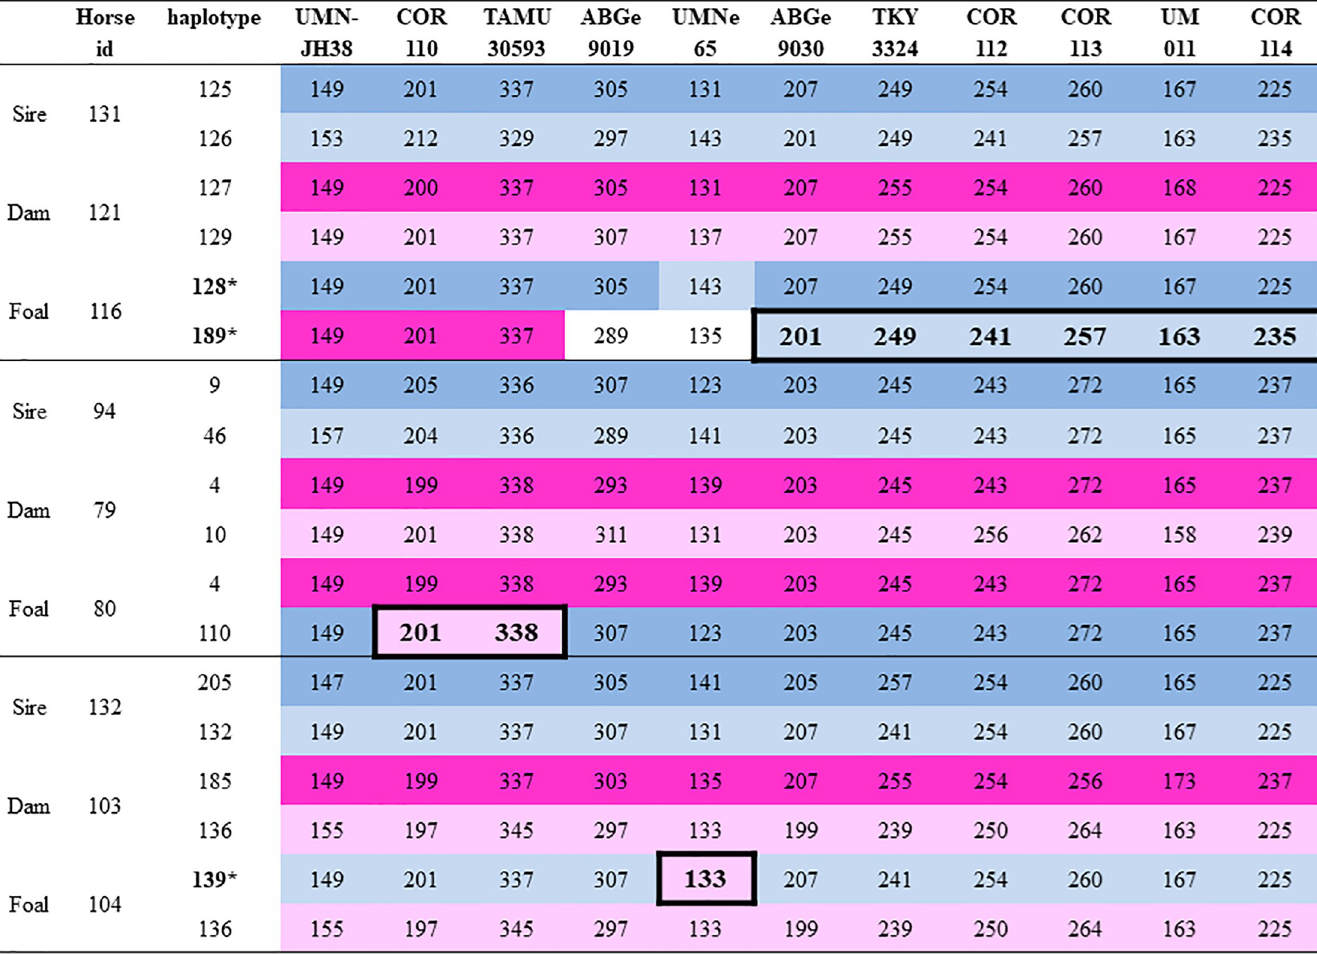
Fig 4. Events of intra-MHC conversion present in the offspring (foal 116, foal 80, foal 104). Fragments of haplotypes which were converted are marked. Every conversion resulted in new haplotype ( �